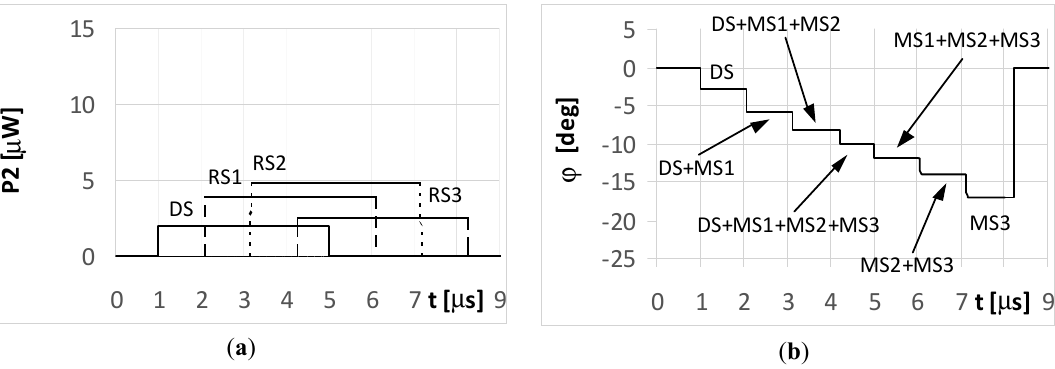
Figure 10. Envelopes of the direct signal (DS) and multipath signals (MS1, MS2, MS3) reflected from the ground, separated in time, and reaching UAV2 (shown in Figure 1) ( a ), and temporary angle of arrival ϕ estimated from the received resultant signal ( b ), (for simple and LFM short pulsed signal transmitted by the radar, pulse duration t i = 1 µ s , and initial phases Φ 0D = Φ 01 = Φ 02 = Φ 03 = 0 ◦ ; AOA was estimated using the monopulse phase method from the DF device installed on UAV2 ).